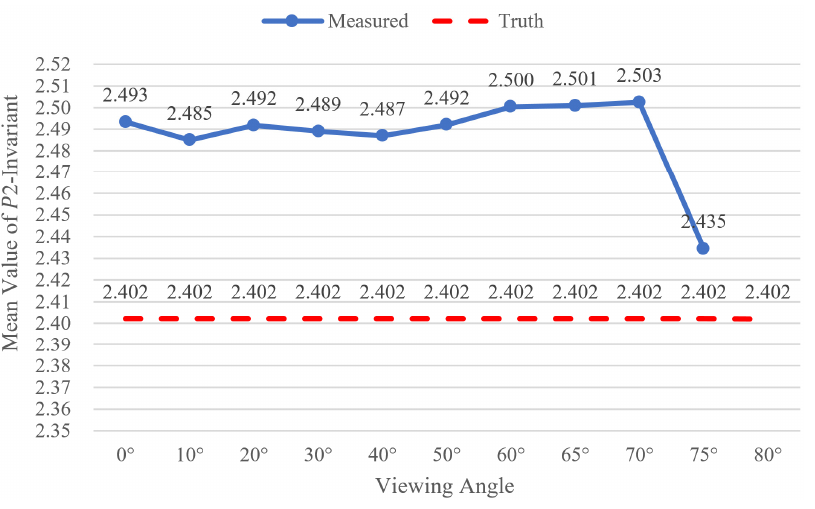
Figure 11. The variation in mean value of P 2 ‐ invariant with increasing steps of viewing angle. For each experiment, the range, mean, and root mean square error (RMSE) of P 2 ‐ invariant values of all GCTs are shown in Table 7. The minimum value is 2.401 and the